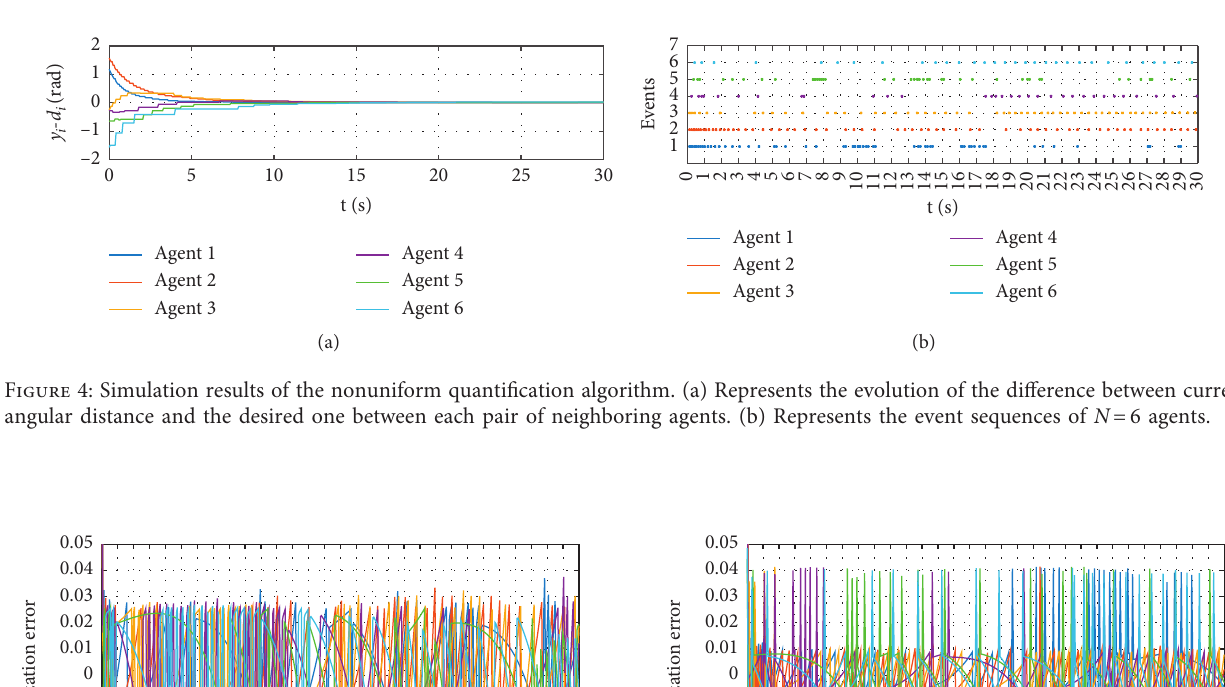
–0.05–0.04–0.03–0.02–0.0100.010.020.030.040.05 Figure 5: Uniform quantization error e